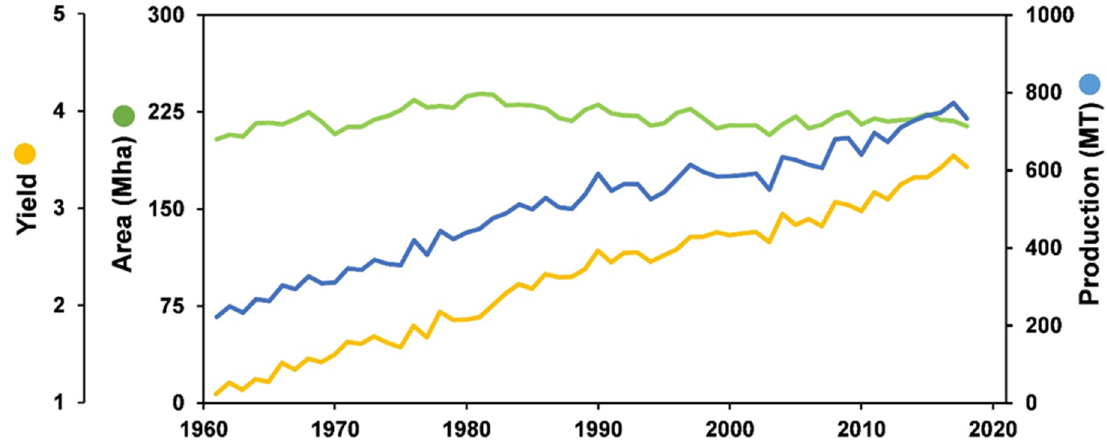
Figure 3. The world wheat production, harvested area, and yield between 1960 and 2018 FAOSTAT [1]. Through the indexmundi database, we were able to verify that China, India, and Russia had a positive production growth rate between the years 2018–2020 while, on the contrary, the USA had a decreased production growth rate [49].